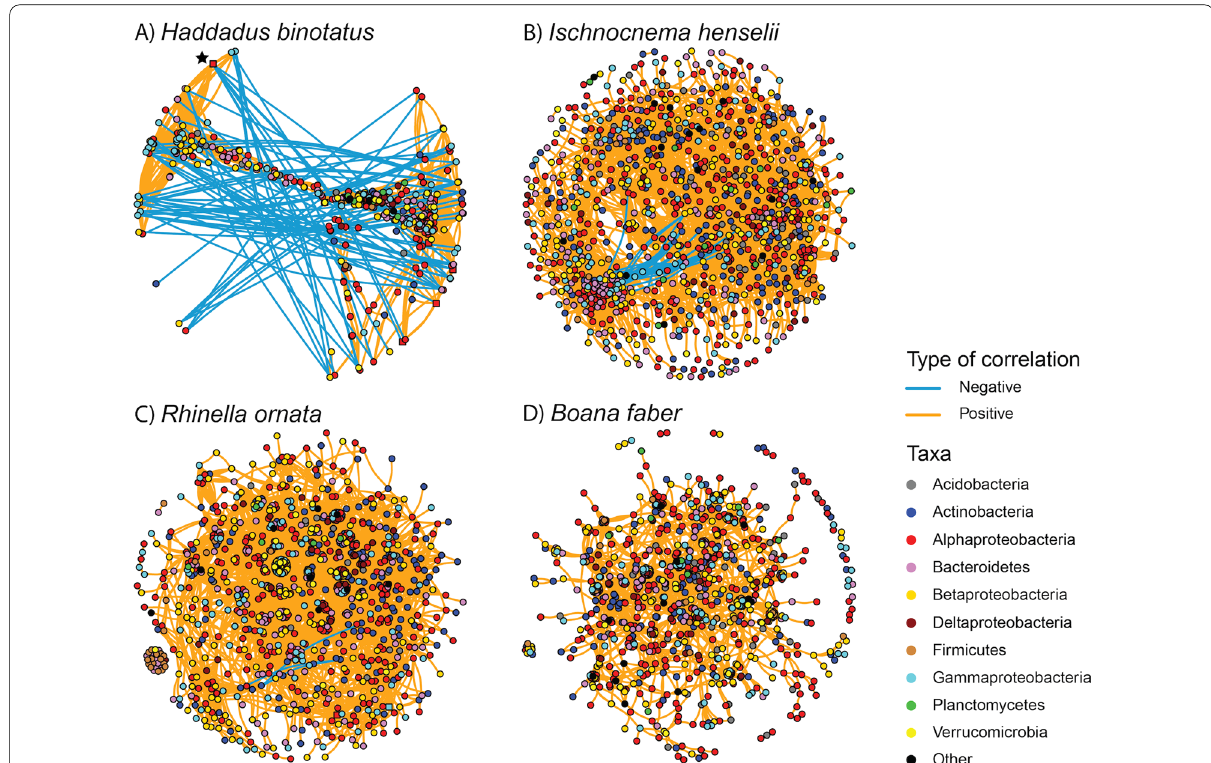
Fig. 4 Correlation‑based bacterial networks for the Serra do Japi landscape using Spearman correlations (coefficient ρ > 0.6 and < and the Fruchterman‑Reingold layout. Colored points indicate nodes (sOTUs) and lines indicate edges (positive or negative correlations). Nodes (sOTUs) are color‑coded based on bacterial phylum or class (in the case of Proteobacteria). Square‑shaped nodes represent common core sOTUs (90%). In the Haddadus binotatus network, the common core sOTU classified as Alphaproteobacteria and shown at the top left of the network (marked with a black star) ranked highest in betweenness centrality. Edge lengths are a function of layout and are not biologically